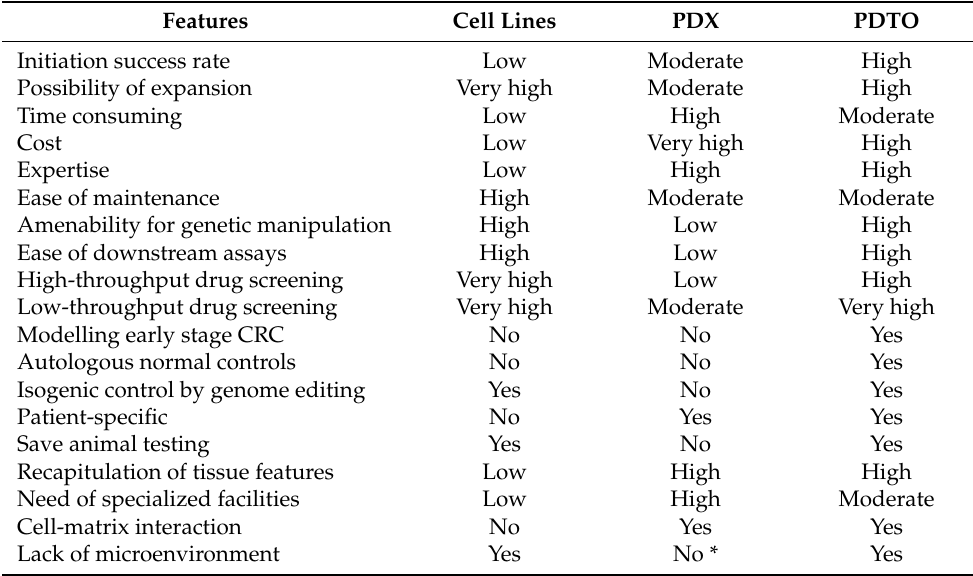
Table 2. Comparison among patient-derived colorectal cancer model